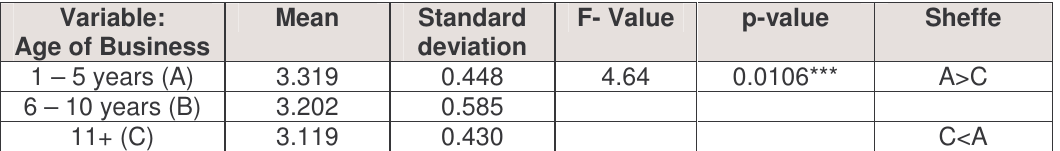
Table 3: ANOVA between different starting dates (age of business) regarding Personal Management